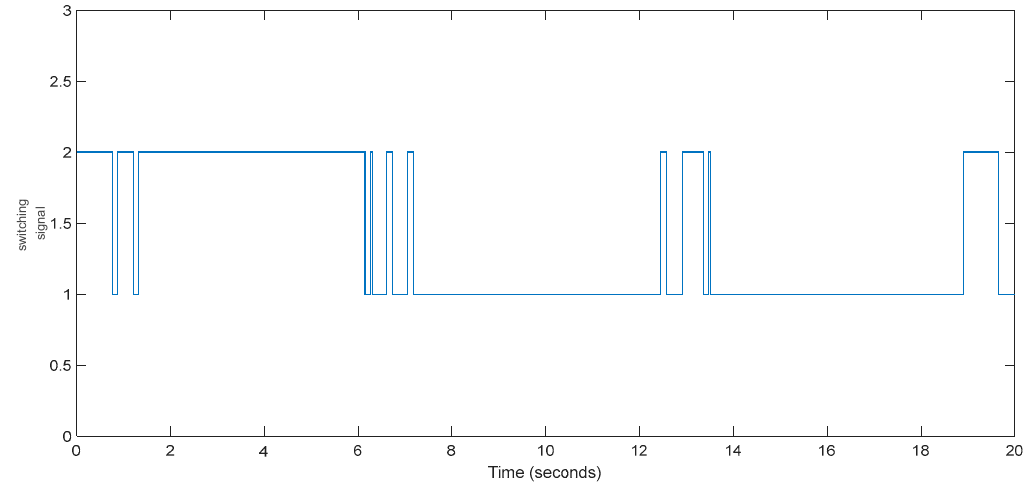
Figure 7. The selected switching signal in (19).